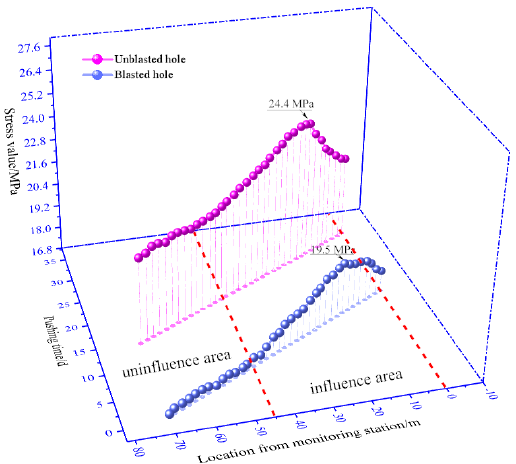
Figure 13. Coal pillar internal stress gauge monitoring curve.